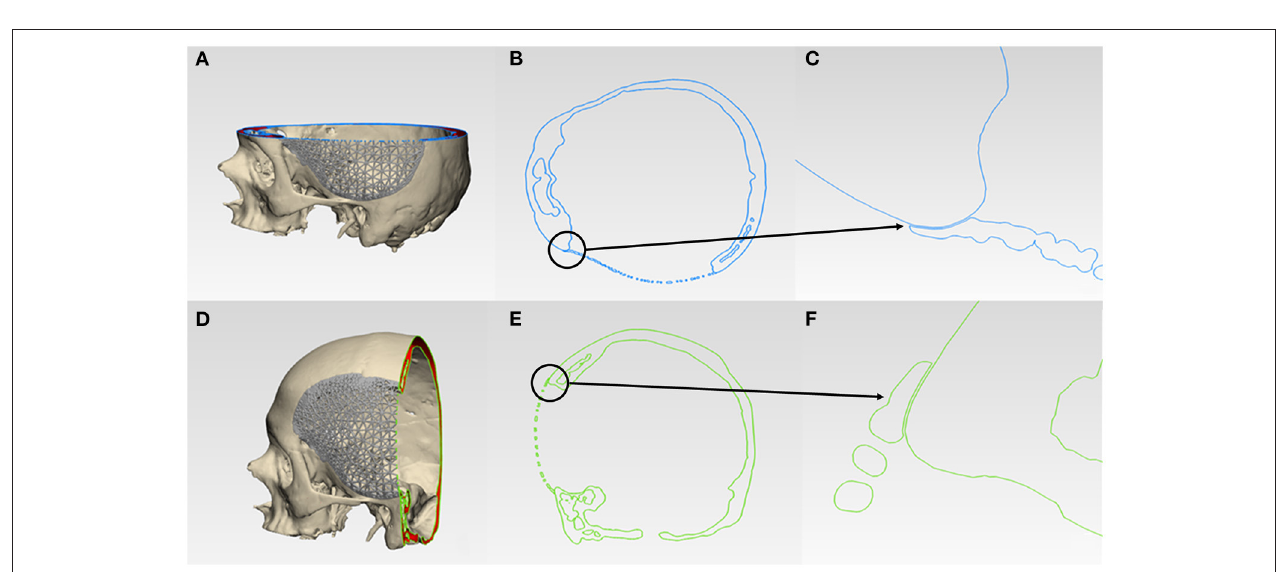
FIGURE 6 | Virtual morphological fit and contour continuity analysis of wireframe/lattice Voronoi pattern customized cranial prosthesis. (A) Cutting plane in the Z-direction (blue). (B) Cross-sectional analysis along the z-axis. (C) Magnified view of the cross-sectional analysis along the z-axis. (D) Cutting plane in the Y-direction (green). (E) Cross-sectional analysis along the y-axis. (F) Magnified view of the cross-sectional analysis along the y-axis.